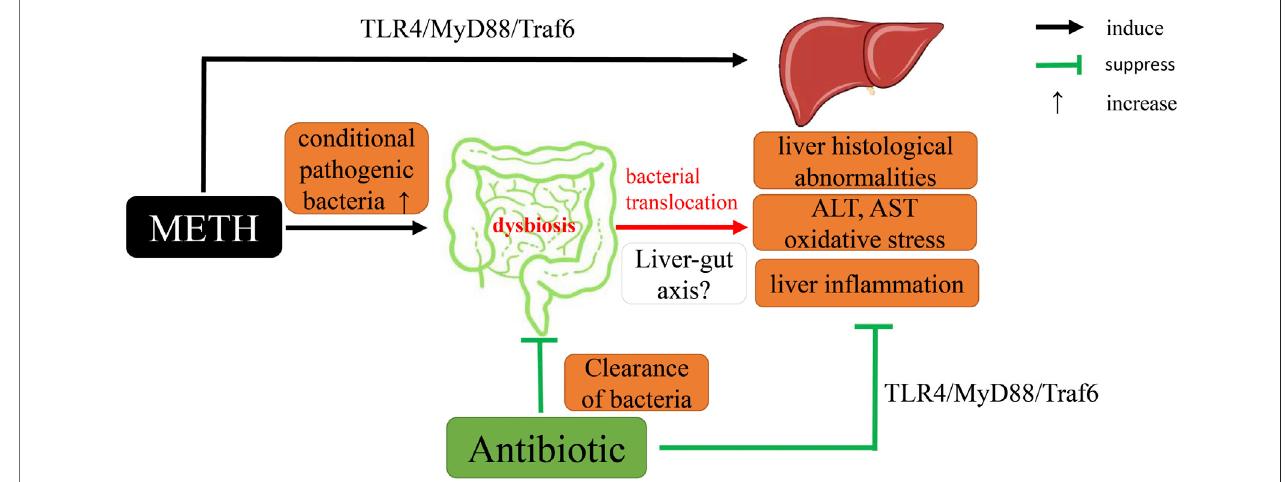
FIGURE 9 | A proposed mechanistic diagram of antibiotic protective action on METH-induced liver hepatotoxicity in this study.